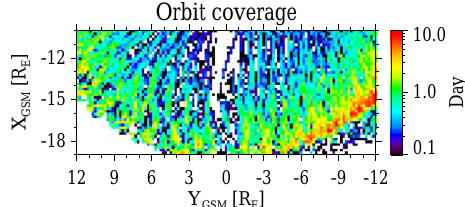
Figure 5. The orbit coverage of all four Cluster satellites in the XY plane. Bin size is 0.2 R E . If at least two satellites are simulta- neously in the same bin, we only count the time once for that bin.